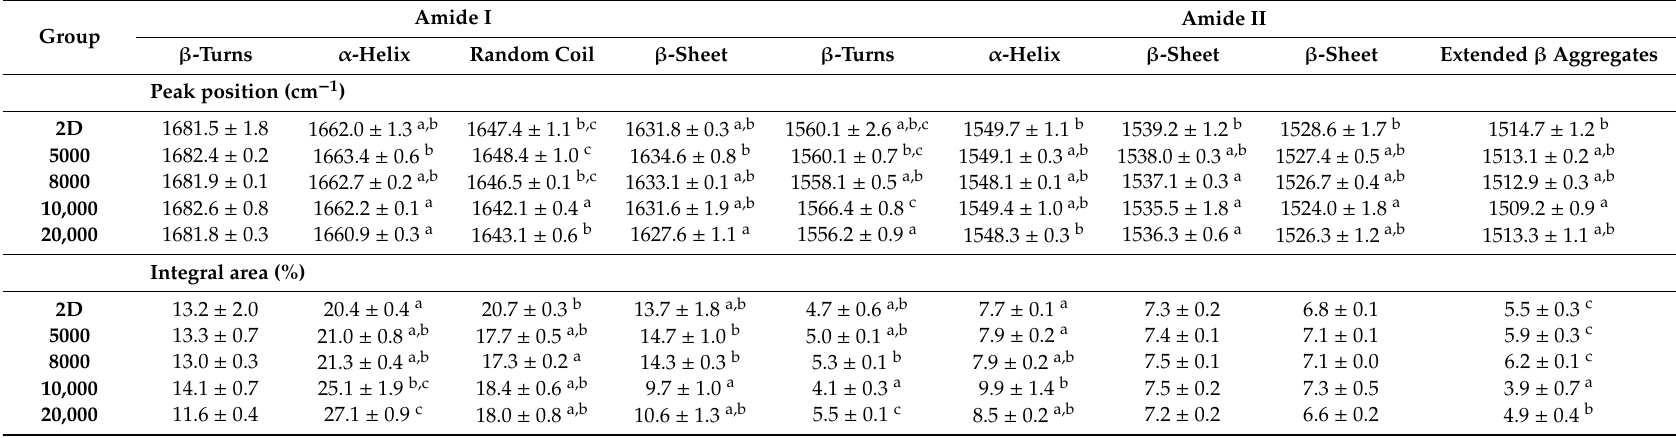
Table 2. Peak positions and integral area of secondary structure of protein between the 2D cells and groups of 3D spheroid cells. Data are expressed as mean ± standard deviation (SD) of three replicates. Different superscripts in the same column indicate significant differences between groups ( p < 0.05). Amide I Amide Group